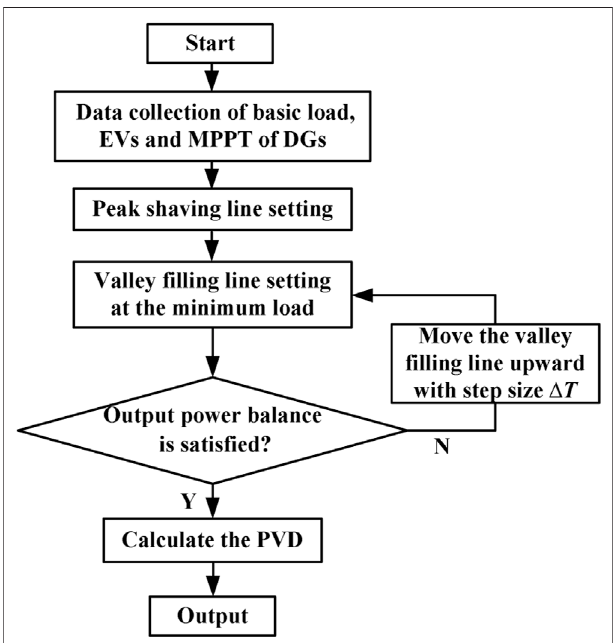
FIGURE 7 | Variable power charge/discharge control fl ow of the